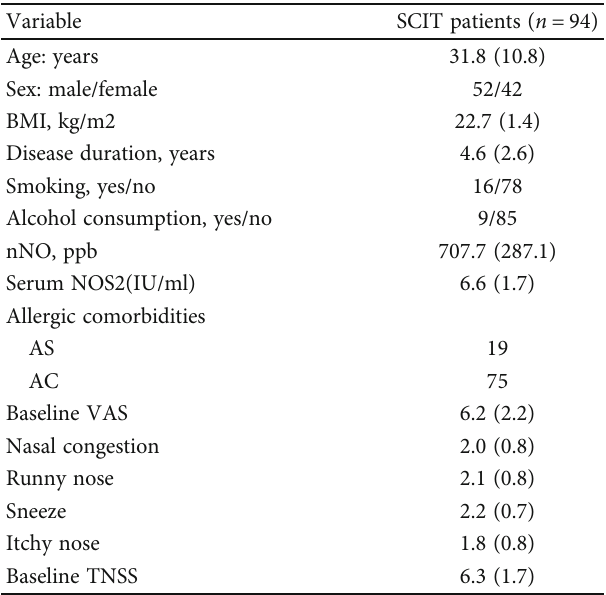
Table 2: Baseline characteristics of the SCIT